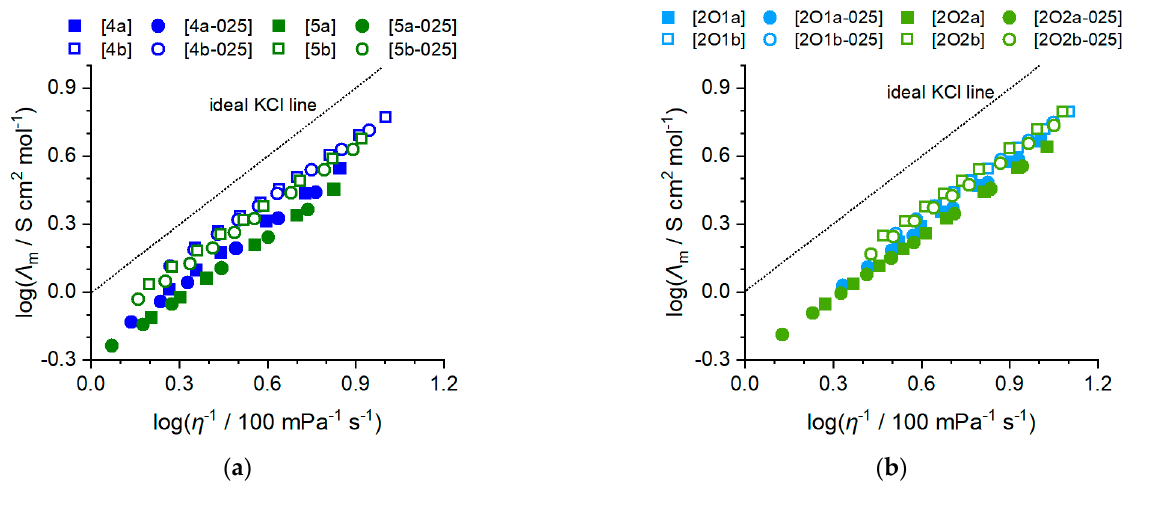
Figure 7. Walden plots of the electrolyte samples. ( a ) n ‐ alkyl phosphonium ionic liquids and salt mixtures; ( b ) Ether ‐ containing phosphonium ionic liquids and IL–salt mixtures. The dotted black line corresponds to the bisection, often termed the ‘ideal KCl line’ in the literature.